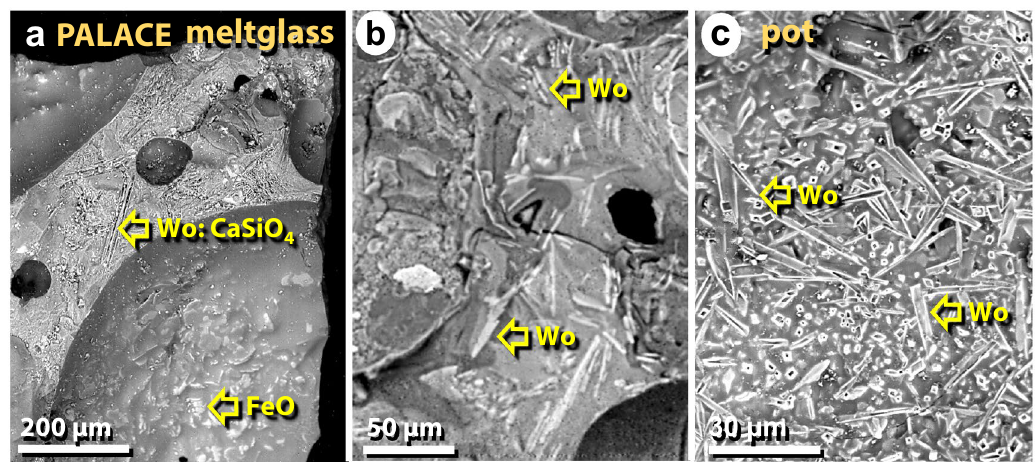
Figure 43. SEM images of wollastonite crystals in palace melted pottery and mudbricks. ( a ) Spindle-like crystals of wollastonite (CaSiO 4 ) on the broken face of mudbrick meltglass. Crystals of iron oxide line the vesicle. ( b ) Wollastonite crystal within the meltglass matrix. ( c ) Wollastonite crystals within a vesicle of melted